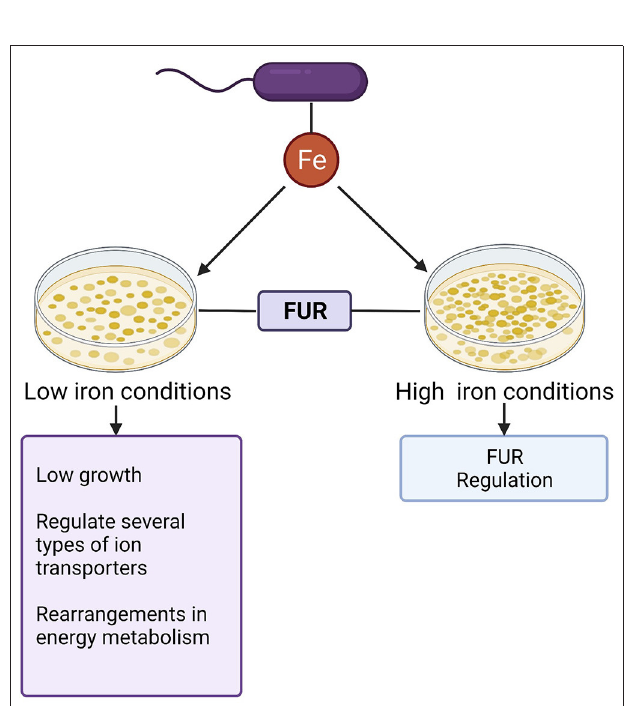
FIGURE 2 | Role of iron in C.difficile homeostasis: Iron (Fe) represents a key cofactor for C.difficile homeostasis. The ferric uptake regulator (Fur) contributes to the control of intracellular homeostasis in both low high iron